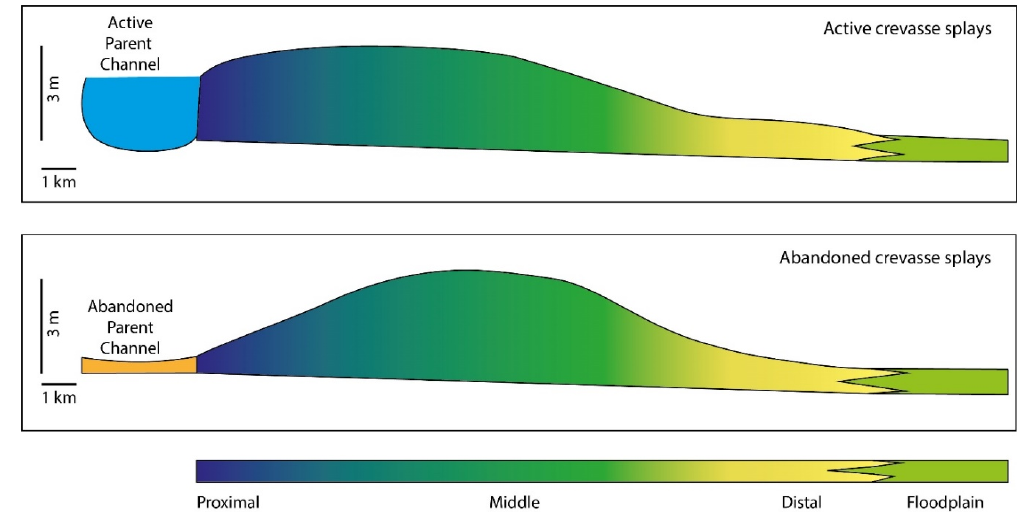
Figure 15. Along-dip conceptual altimetric profiles of typical active and abandoned crevasse splays as inferred from this research. Crevasse splay sections terminology according to Figure 1.